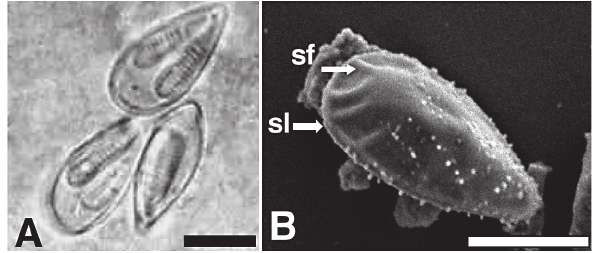
Fig. 1. – Mature spores of Myxobolus cuneus n. sp. A - light pho- tomicrographs. Scale bar = 5 µm. B - scanning electron image sho- wing the sutural folds (sf) and the suture line (sl). Scale bar = 5